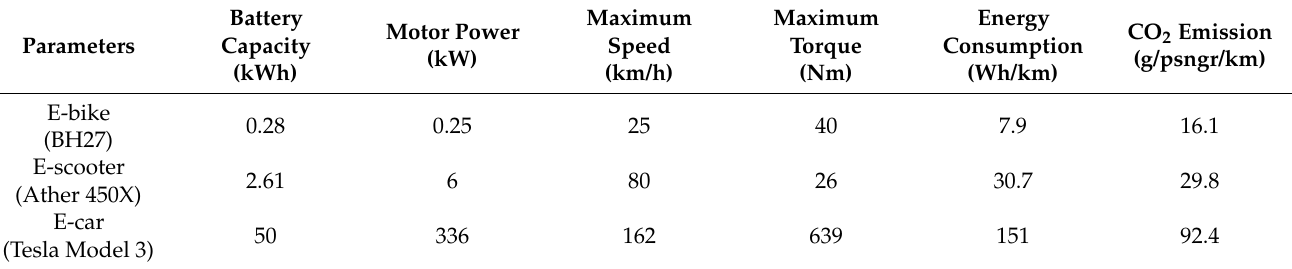
Table 2. Different electric vehicle parameters and CO 2 emission of electric